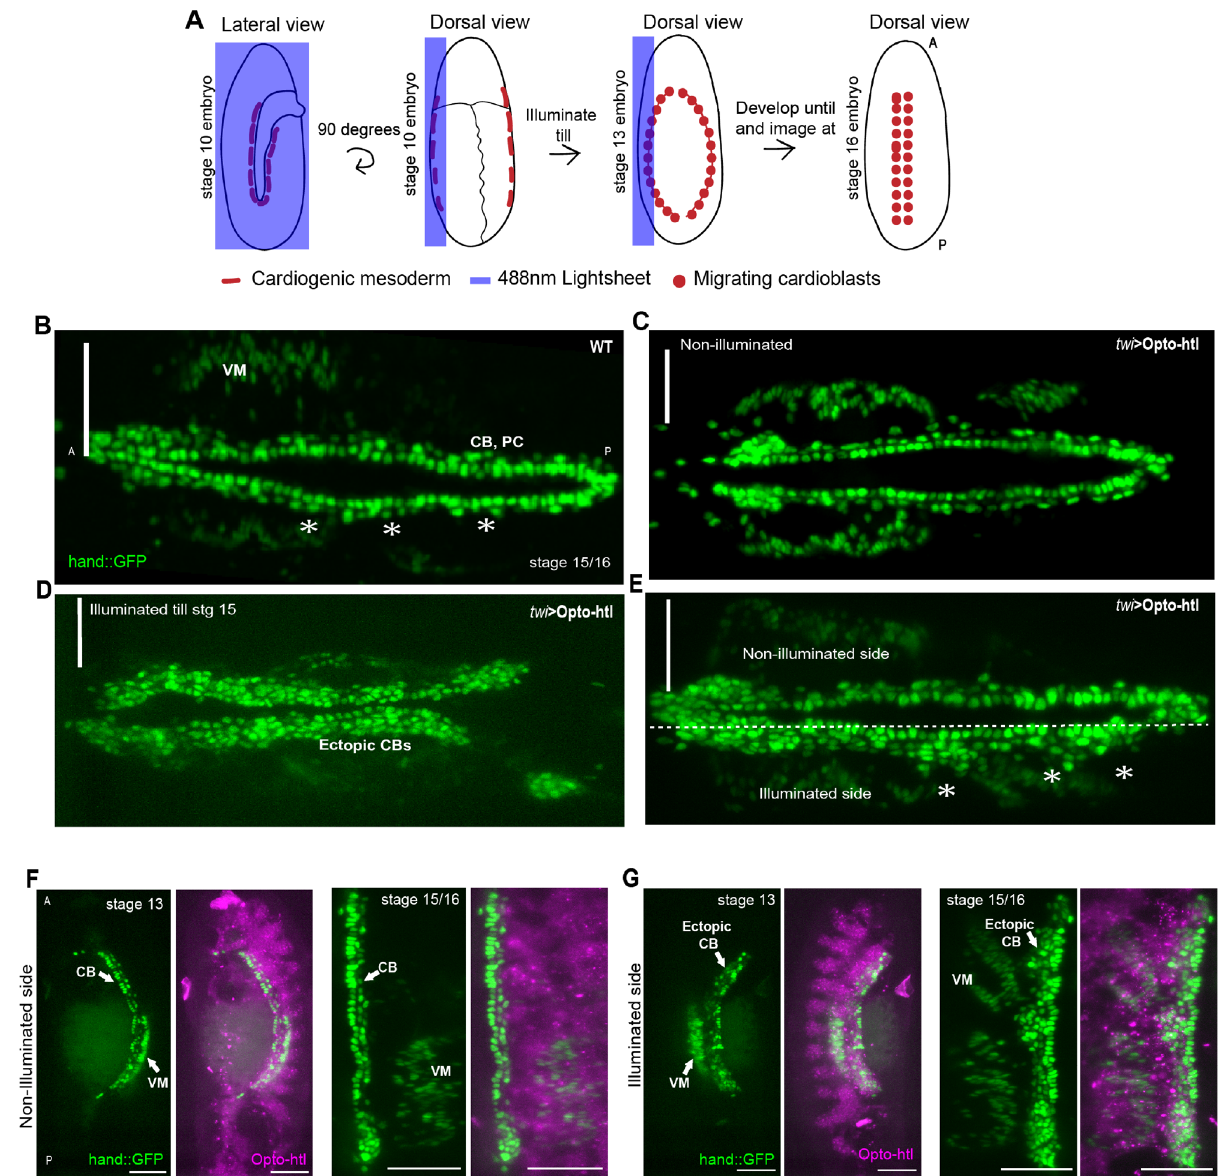
Figure 4. Spatial control of Opto-htl activation. ( A ) Schematic of the imaging protocol for half-illumination of embryos on a light-sheet microscope. ( B ) Dorsal view of a control embryo expressing hand ::GFP. ( C ) twi ::Gal4 > hand ::GFP;Opto-htl embryo kept in dark and imaged at stage 15. ( D ) twi ::Gal4 > hand ::GFP;Opto- htl embryo fully illuminated from stage 5 till stage 15. ( E ) Dorsal view of a twi ::Gal4 > hand ::GFP;Opto-htl embryo illuminated as described in ( A ) and imaged at stage 16. ( F ) Non-illuminated and ( G ) illuminated sides of a twi ::Gal4 > hand ::GFP;Opto-htl embryo. Left panels, stage 13. Right panels, stage 15/16. VM = Visceral mesoderm, CB = Cardioblasts, PC = Pericardial cells. Scale bar = 50